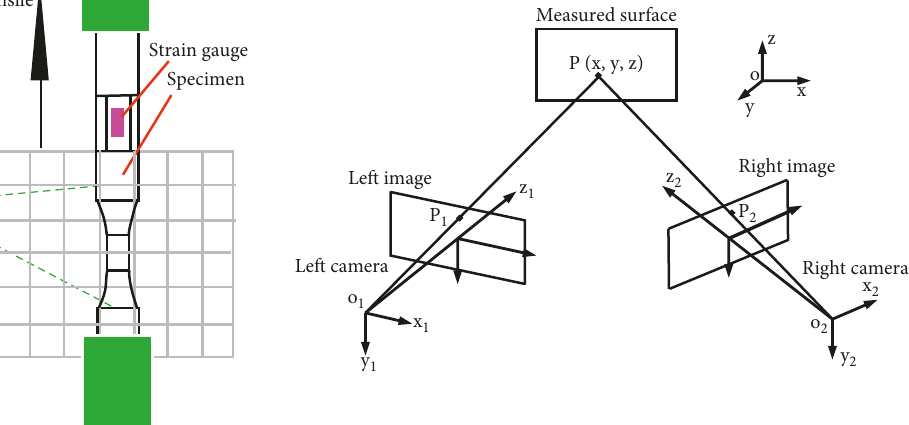
Figure 5: Test apparatus.